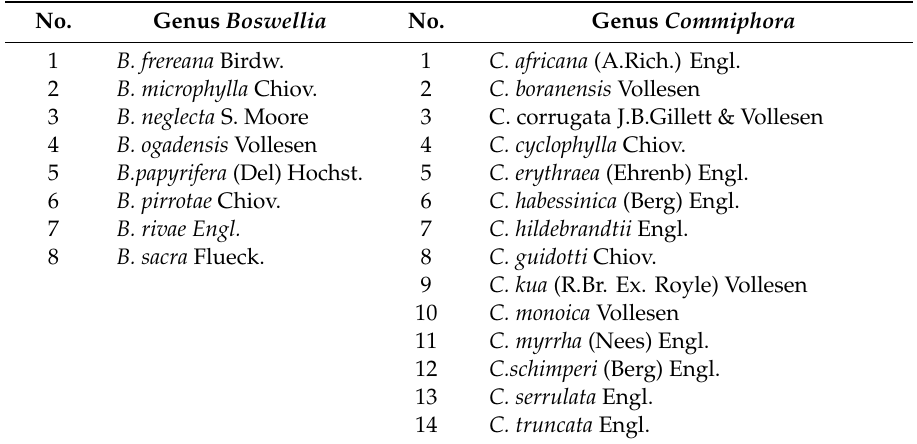
Table 4. List of aromatic resin bearing trees and shrubs in the Horn of Africa by genus and species